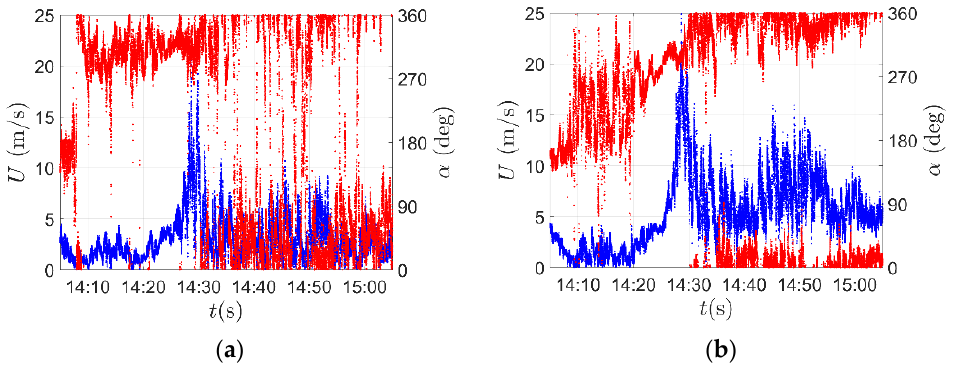
Figure 5. Wind speed (blue) and direction (red) time history of the thunderstorm event recorded at 16 m ( a ) and 64 m ( b ) .